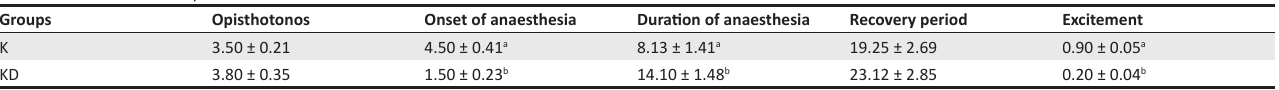
TABLE 1: Rate of opisthotonos and time taken in minutes for onset of anaesthesia, duration of anaesthesia and recovery period in pigeons treated with ketamine only and a ketamine and diazepam combination. Groups